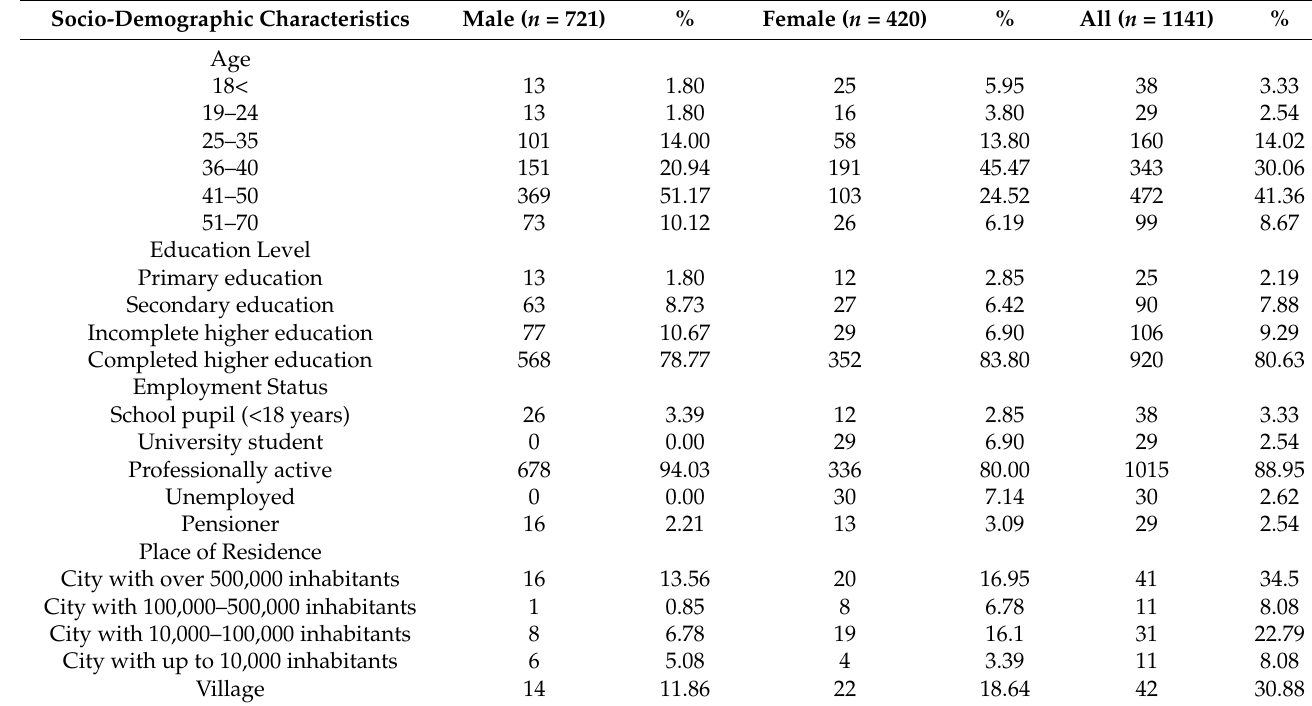
Table 1. Socio-demographic characteristics of